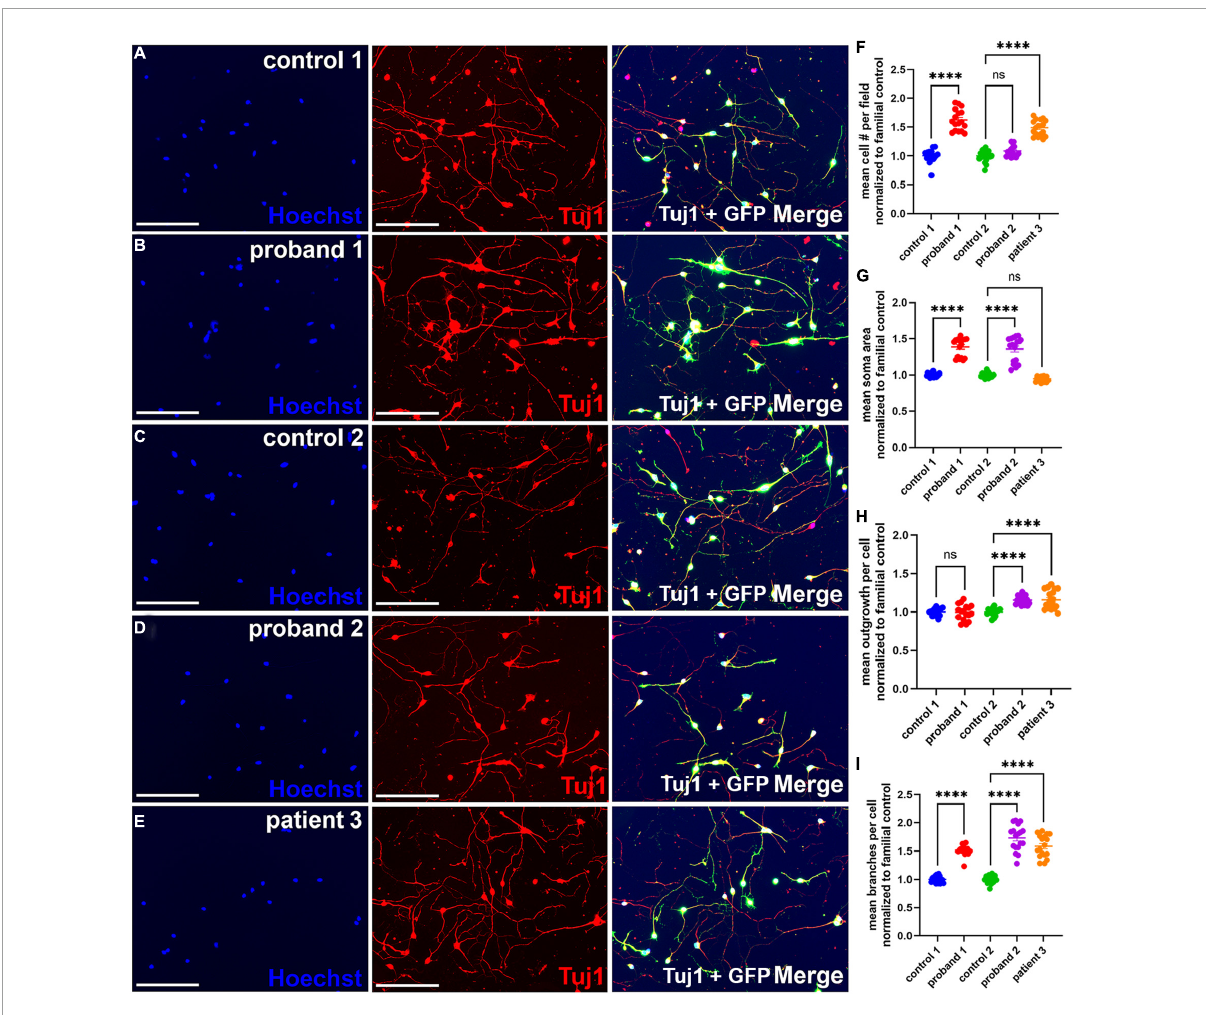
FIGURE2 Increased neurite branching in 16p13.11 deletion iPSC-derived NGN2 neurons. (A–E) Representative images of day 7 16p13.11 proband and control iPSC-derived neurons immunostained with Hoechst (blue), with GFP signal from lentiviral induction (green), and Tuj1 (red). All images taken at 10X. For all lines, 9 fields were imaged per well, 5 wells per line, and 5 separate differentiations were compiled for the subsequent quantification. (F) Quantification of the mean neuronal cell number per field revealed an increase in 2 of 3 patients. (G) Quantification of the mean soma area revealed an increase in 2 of 3 patients. (H) Quantification of mean outgrowth per cell revealed an increase in 2 of 3 patients. (I) Quantification of mean branches per cell revealed an increase in all three patients. Scale bars = 300 µ m. In panels (F–I) data are shown as ± SEM, each data point represents a mean well value averaged from 9 fields per well across 3 differentiations, n.s. = not significant, ∗∗∗∗ p < 0.0001. Pseudo-coloring was applied to allow for merged